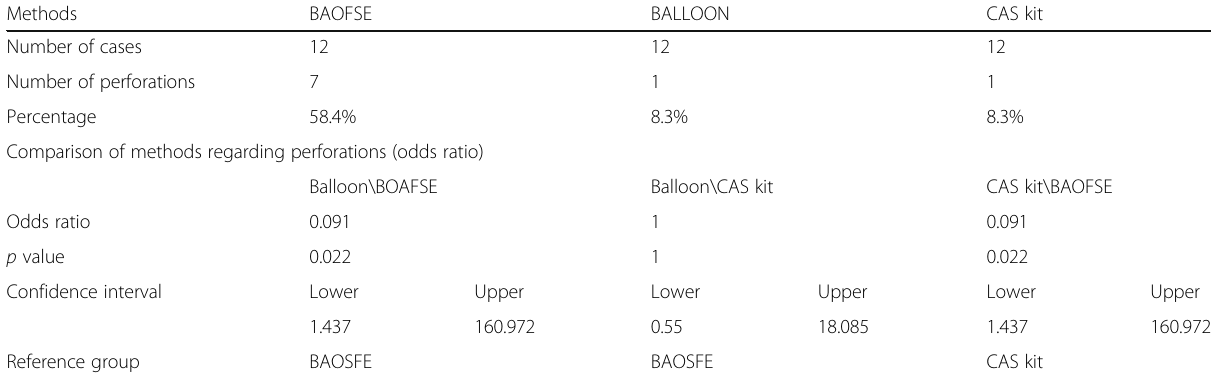
Table 2 The results of logistic regression of method used on the occurrence of perforation